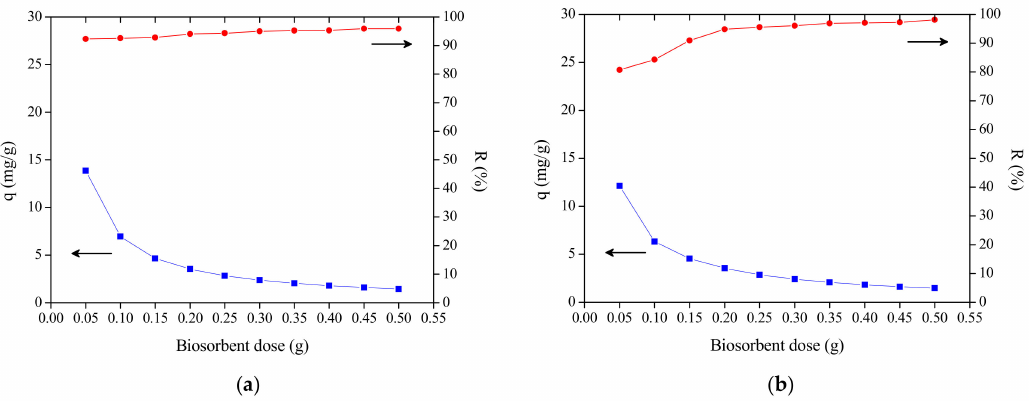
Figure 3. Biosorbent dose vs. biosorption capacity vs. percentage of removal: ( a ) PMT and ( b )